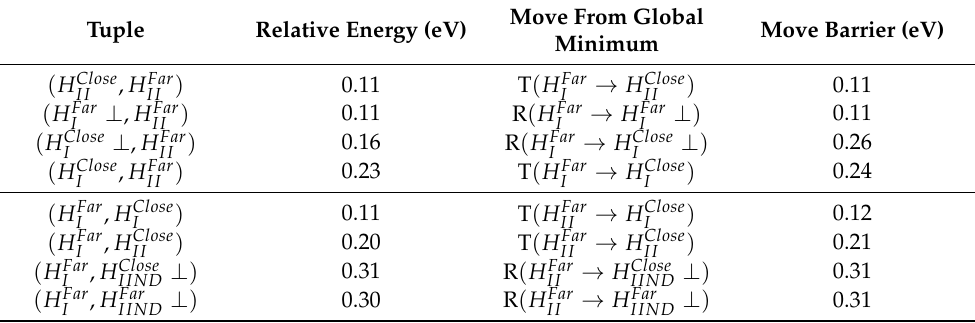
Table 1. The energies of the minima superimposed in Figure 1 relative to the global minimum ( H Far ) are shown along with the single proton motion needed to get to the minimum from , H Far I II ) . The top set are minima resulting from a move from the H Far the global minimum ( H Far , H Far I II while the lower set results from a proton move from the H Far site. Within each region, the sites are II organized by energy. Proton sites perpendicular to the plane in Figure 1 have the ⊥ symbol added to clarify their